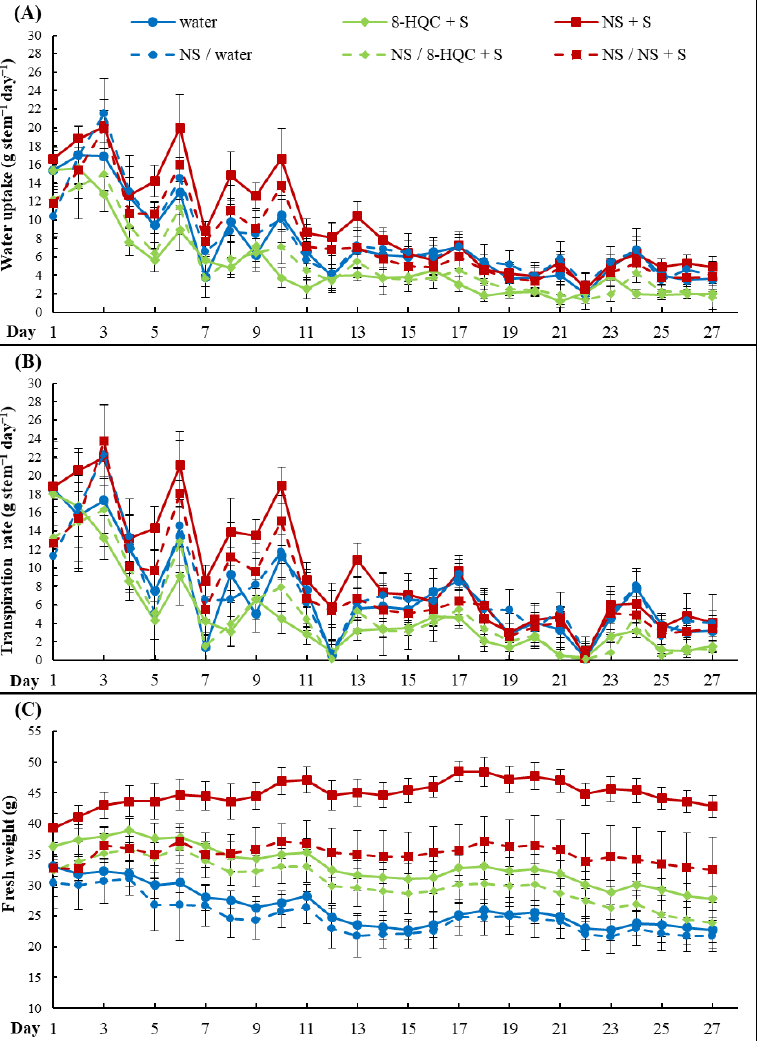
Figure 2. The effect of preservatives on the water balance in cut lisianthus flowers. Water uptake ( A ), transpiration rate ( B ), and fresh weight ( C ) of cut lisianthus flowers. The transpiration rates are shown in Figure 2B. On Day 1, the transpiration of non- conditioned stems was higher than that in the conditioned stems, ca. 18 – 19 g versus 11 – 13 g per stem. The intensity peaked on Day 3, being the highest in conditioned stems in water and in NS + S (22 – 24 g per stem). The general tendency of the transpiration rate was com- parable to that of the water uptake, with peaks and drops every few days, and a gradual reduction in all treatments over time. The volumes of water loss were the lowest in con- ditioned and non-conditioned stems into the standard preservative. The amount of tran- spired water on the last day ranged between 1 g (8-HQC + S) and 4 g (NS + S) per stem. Changes in the fresh weight of stems during the vase life are shown in Figure 2C. They were gradual and devoid of dramatic day-to-day changes. Stems kept in water started losing weight after 4 – 5 days. Their weight dropped by 25 – 30% during 27 days, to ca 23 g at the end of experiment, less than that in stems in preservative solutions. Stems in the 8-HQC + S solution had lower fresh weight after 27 days relative to the initial value, but started losing weight later than those in water, after 11 – 12 days. Stems in the NS + S solution maintained their fresh weight at higher levels than at the beginning of the exper- iment, which was apparent, especially in the non-conditioned stems, where fresh weight